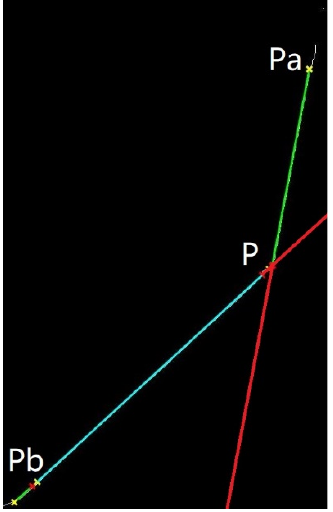
Figure 13. Extraction of the weld feature points.